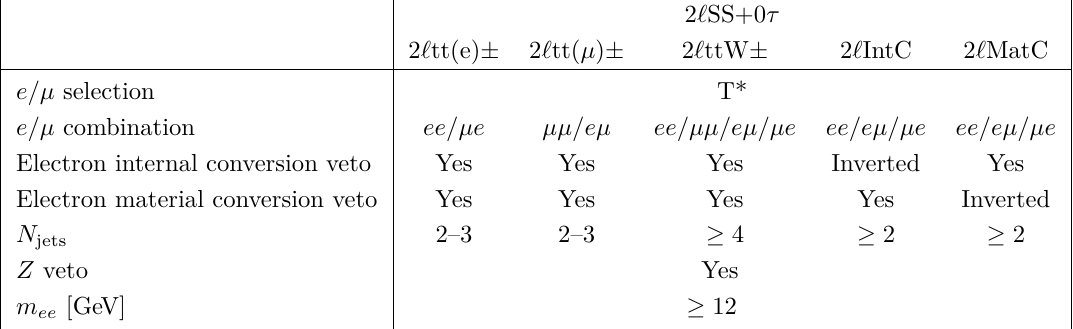
Table 6. Summary of event categories in the 2 ‘ SS+0 τ channel. All events are required to satisfy the preselection requirements. “T*” denotes the Very Tight light-lepton selection criteria (see table 2). Events that belong to the tt(e), tt( µ ), and ttW categories are further split into two CRs for ++ and −− charge events. IntC and MatC stand for internal and material conversions, respectively. The first (second) light lepton quoted in a pair denotes the leading (subleading) lepton in p with resonant e + e − pairs from quarkonia or Z -boson decays due to electron charge misassignment are suppressed by requirements on the dielectron invariant mass ( m